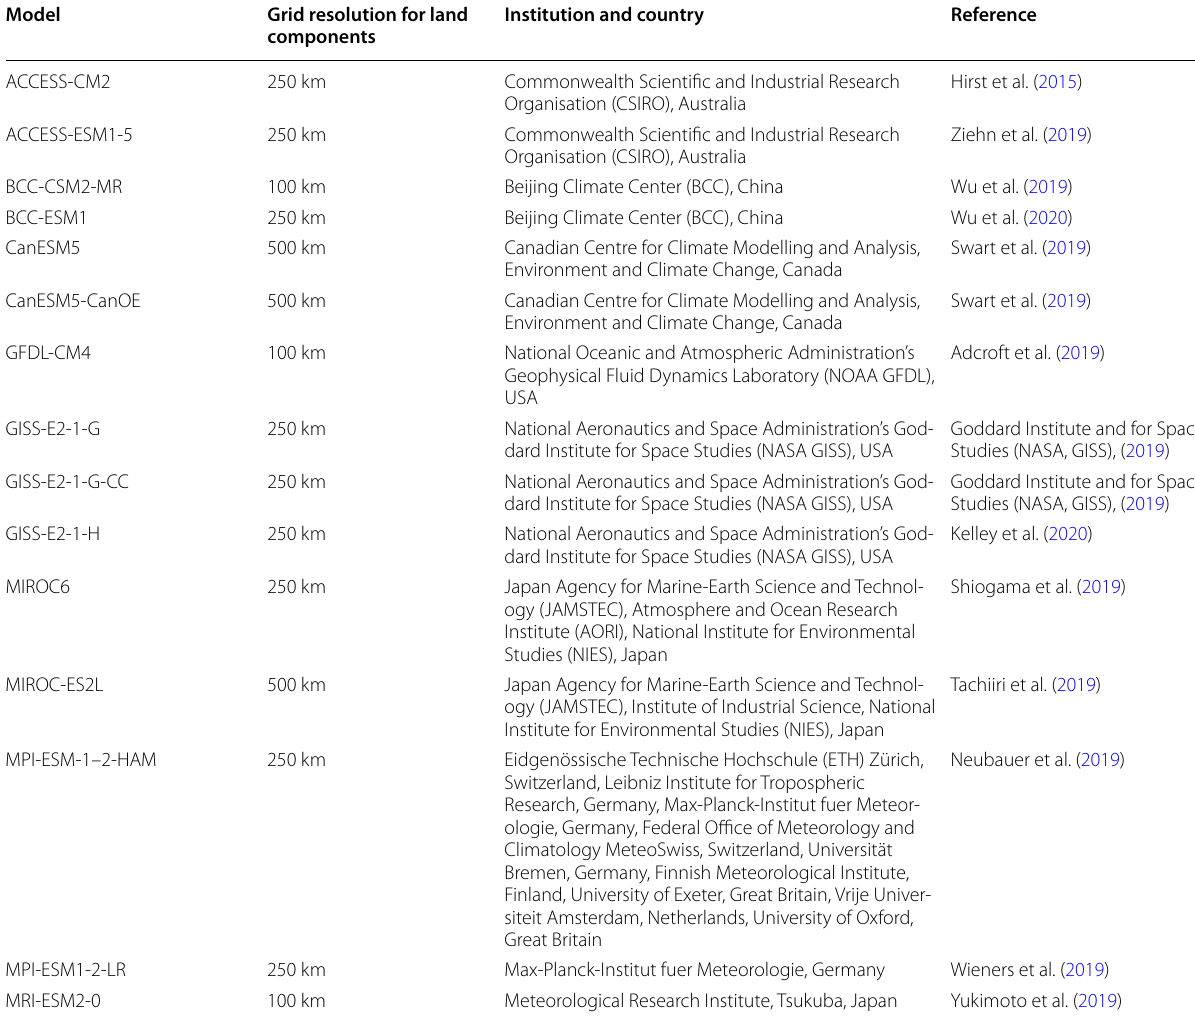
Table 8 List of the CMIP6 global climate models analysed and associated model information